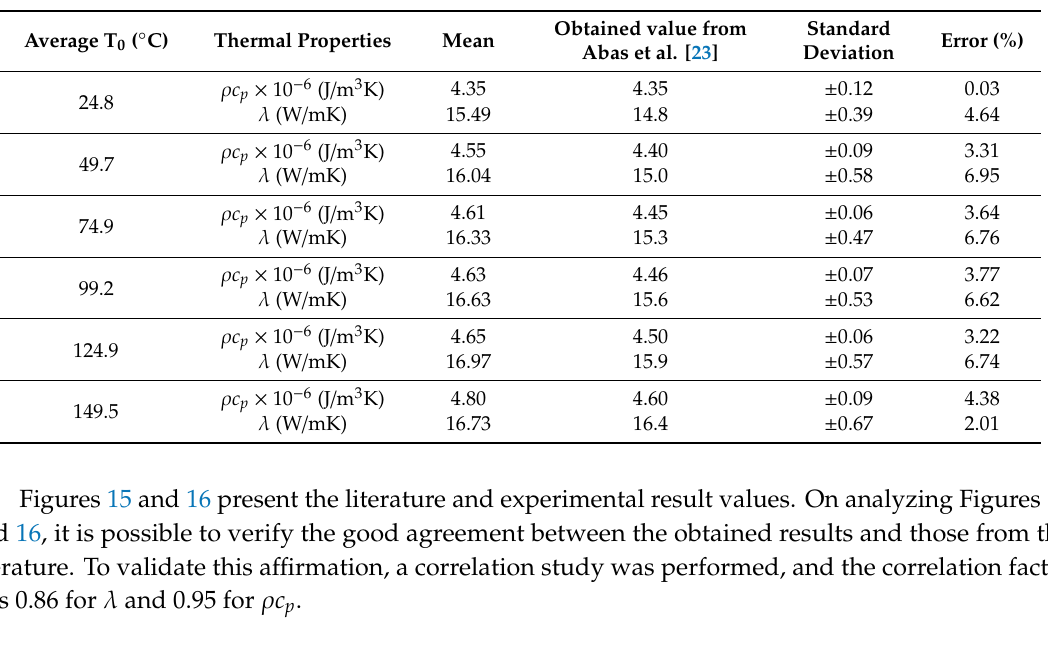
Figure 16. Comparison between the literature values with the estimated results of λ on the AISI 304 stainless steel sample. From these results, Equations (9) and (10) can be written as follows for ρ c p and λ respectively: 𝜆(cid:4666)𝑇(cid:4667) = 0.01067 × 𝑇 + 15.4293 [W/mK] ,